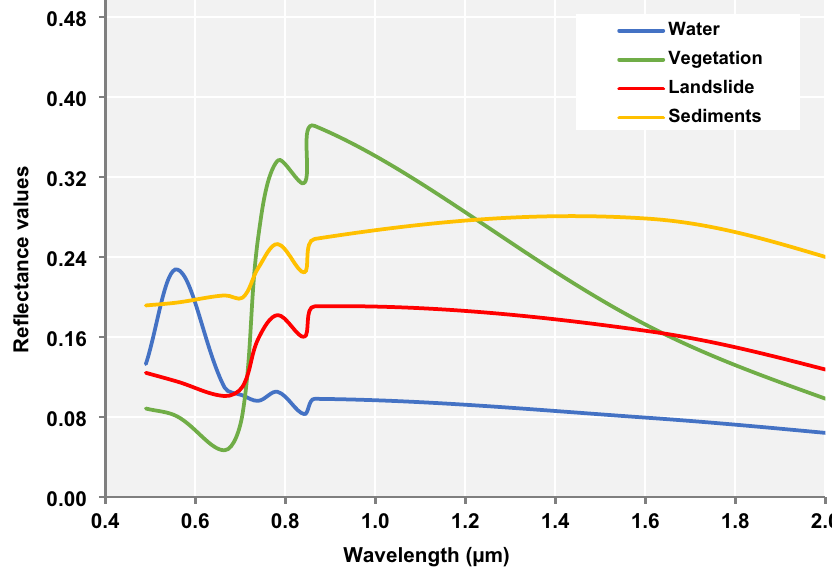
Fig. 10 The spectral signature plot of land classification by RF